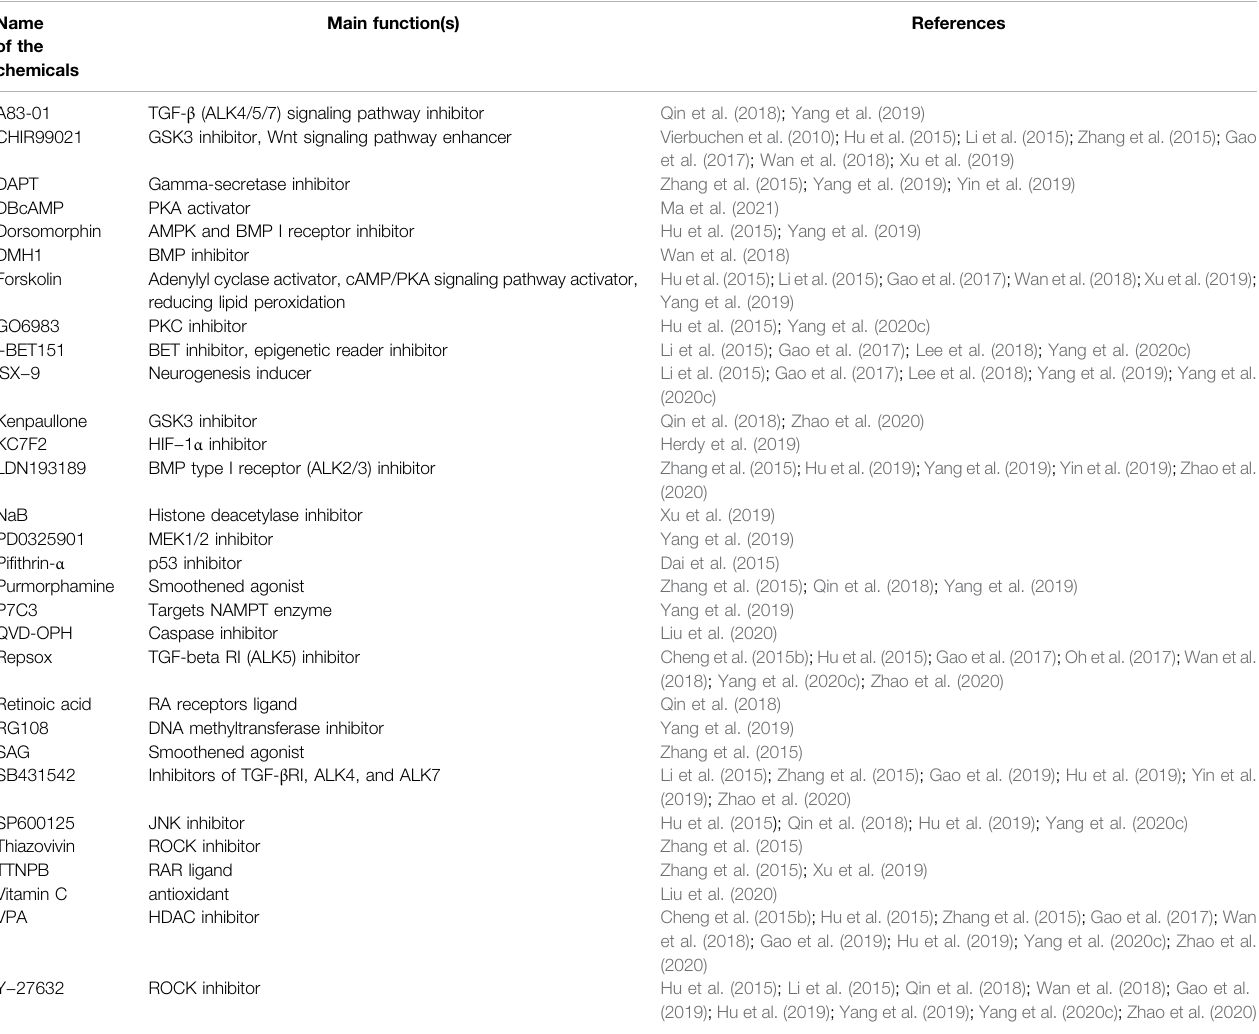
TABLE 1 | The most common small molecules during the transdifferentiation of somatic cells into neurons. Name of